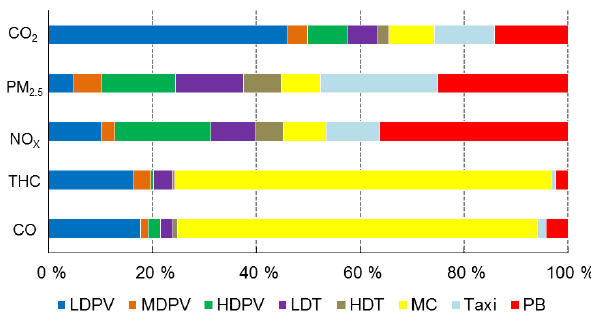
Figure 4. Allocations of total vehicular emissions by vehicle clas-